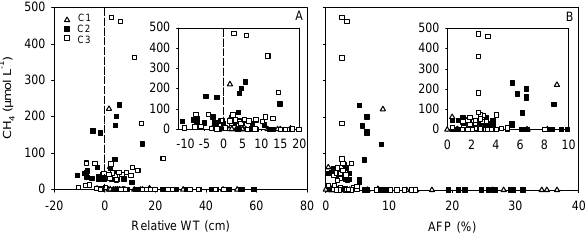
Fig. 5. Relations between dissolved methane with (A) relative wa- ter table and (B) air filled porosity (AFP) in C plots. The relative WT expresses the distance between the water table and the depth at which the sample was obtained; negative values indicated water- saturated peat and positive values refer to water-unsaturated condi- tions. Note the different distribution in relation to differences in peat compaction (refer to Table